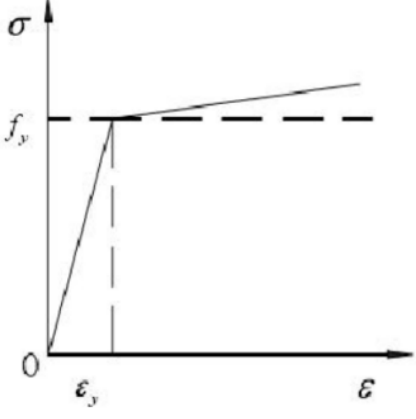
Figure 13. Stress–strain curve of the steel bar.